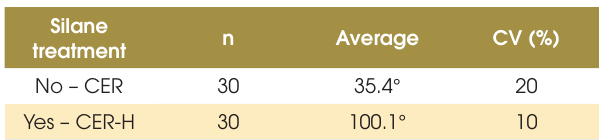
Table 1 – Contact angles between water drops and untreated bricks and bricks treated superficially with silane 60 s after